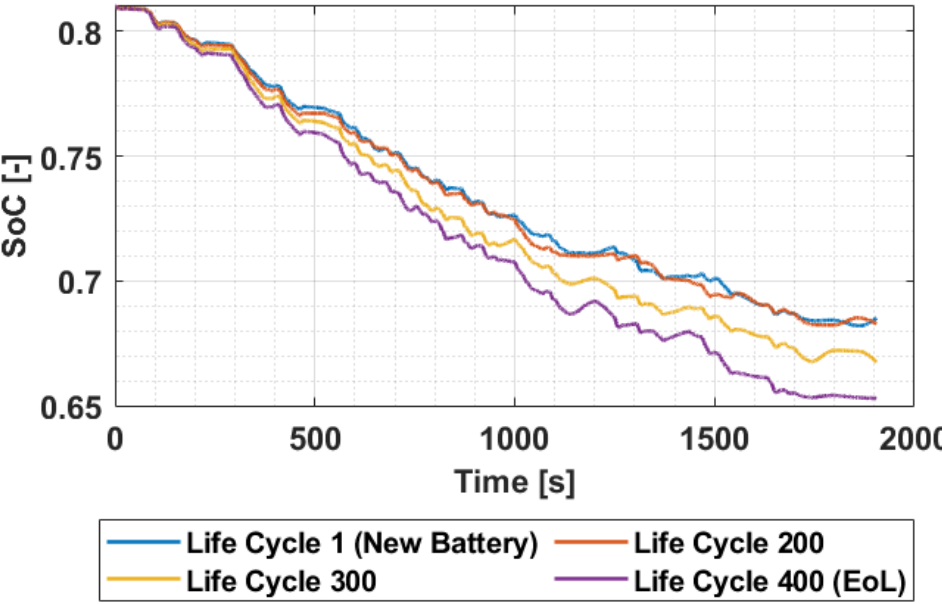
Figure 26. Comparison of the battery SoC trend estimated for different battery ageing levels throughout DM25 in the case of DoD100.